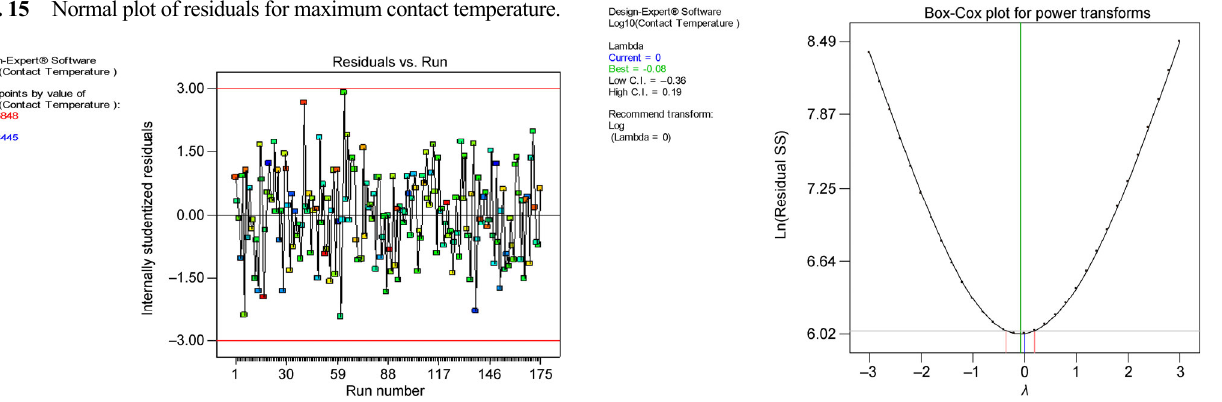
Fig. 18 Box-Cox plot for power transformation in the case of maximum contact